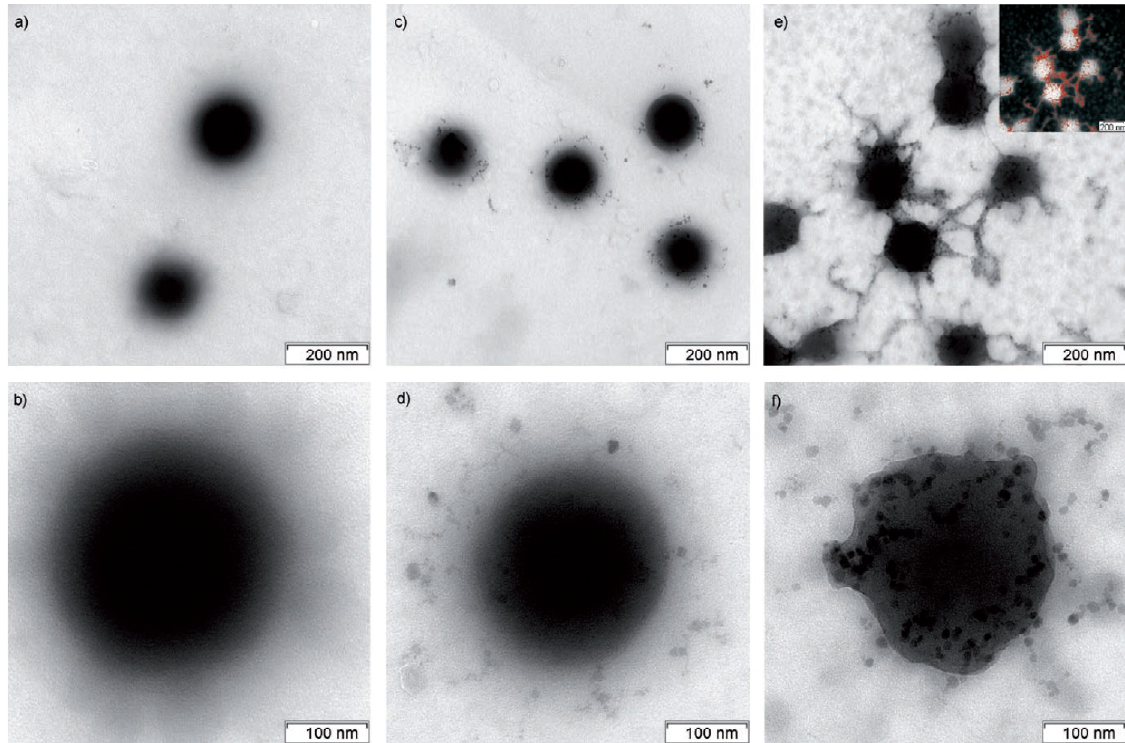
Figure 37. TEM images of microgels for different magnetite contents: ( a , b ) no magnetite; ( c , d ) 8.4 wt%; ( e , f ) 15.4 wt%. Inset: EDX iron-mapping image. Reprinted with permission from [64] Copyright 2007 Wiley-VCH Verlag GmbH & Co.,